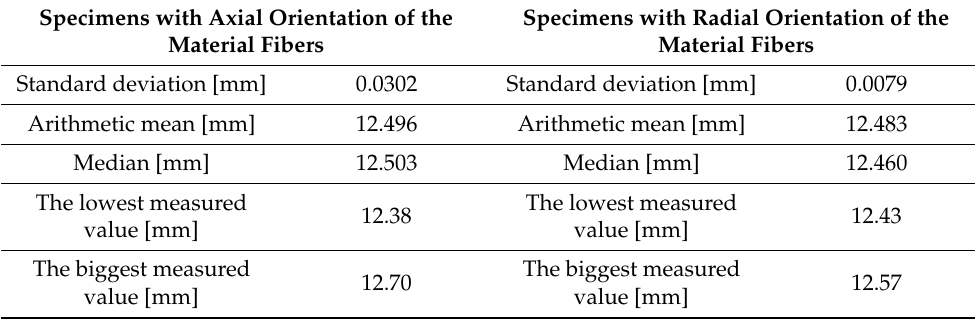
Table 3. Processed data for measuring the functional dimension of the sample width.